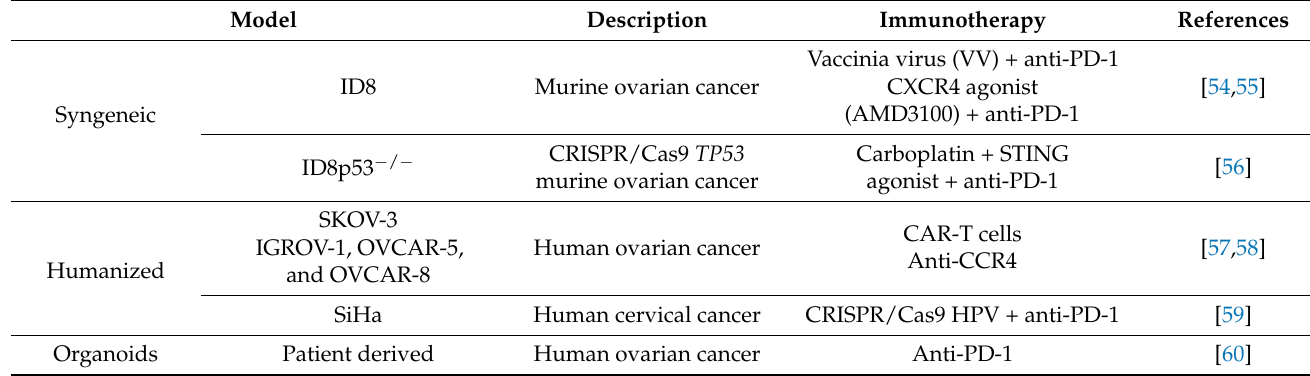
Table 1. Promising preclinical models utilizing immunotherapy interventions in gynecologic